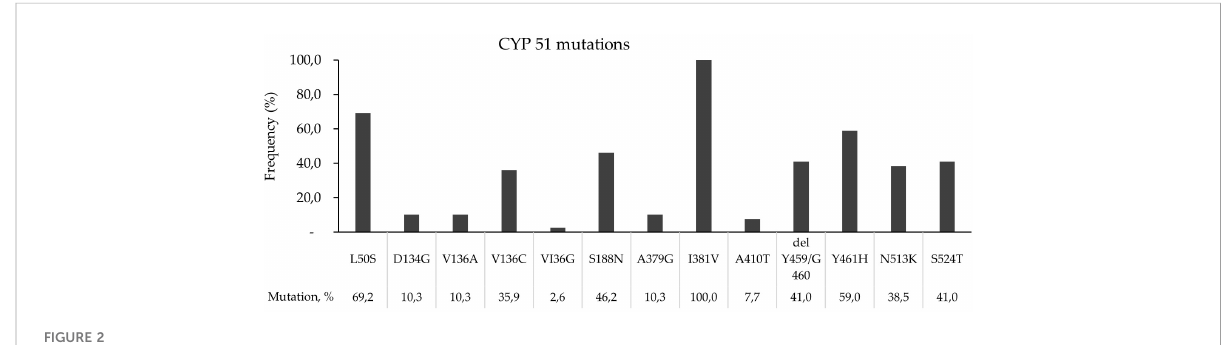
FIGURE 2 Frequency of thirteen most frequent mutations in CYP 51 gene in Lithuania